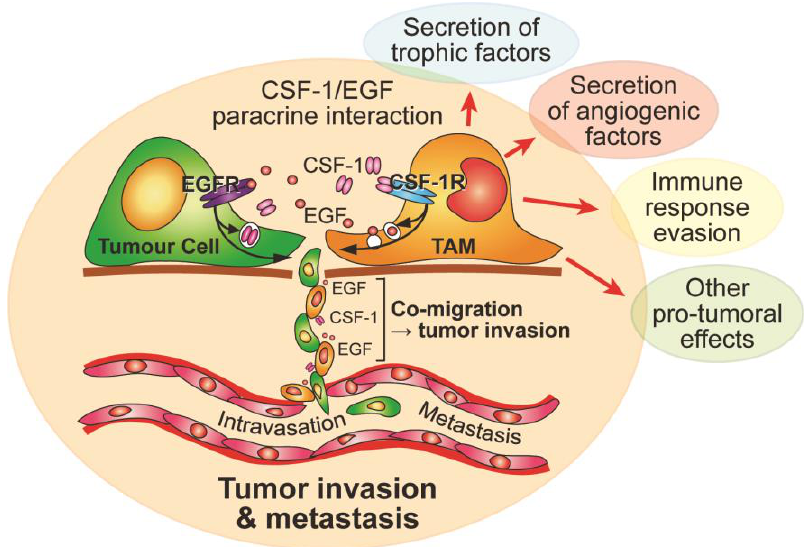
Figure 2. Contribution by tumor-associated macrophages (TAM) to tumor progression with an emphasis on tumor invasion and metastasis. TAMs secrete epidermal growth factor (EGF) and tumour cells secrete CSF-1 to induce a paracrine loop-driven co-migration and invasion of both cell types towards blood vessels.